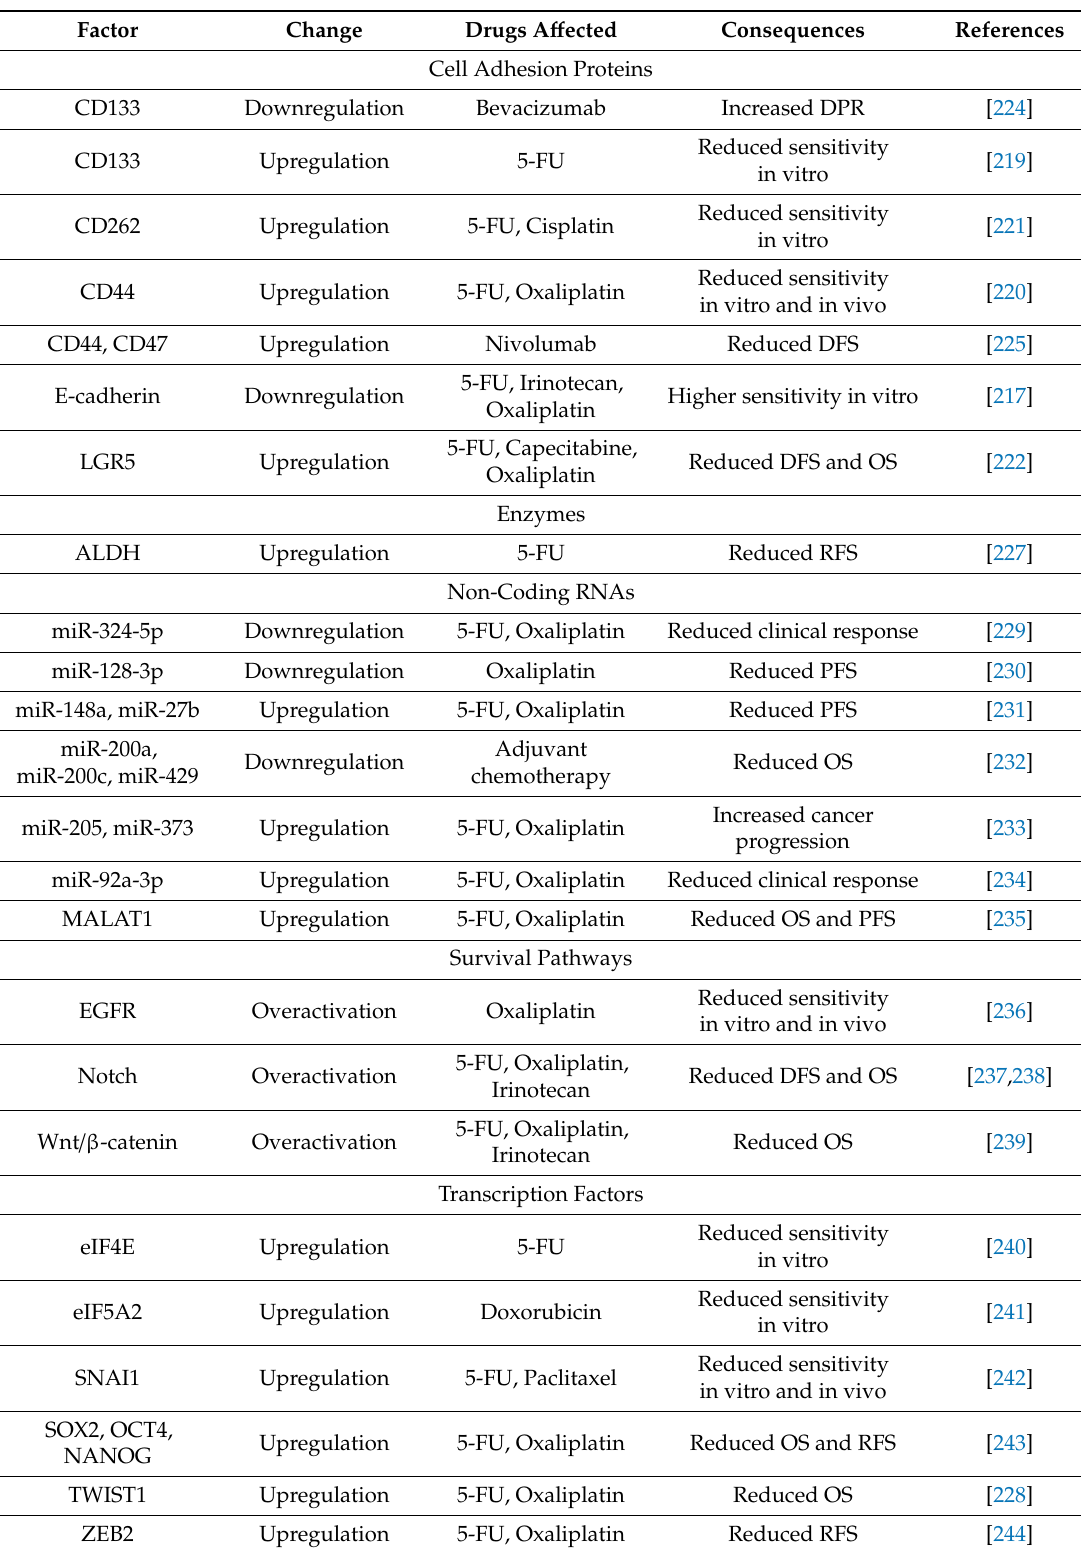
Table 7. Mechanisms of chemoresistance type 7 (MOC-7) in colorectal cancer. Drugs A ff